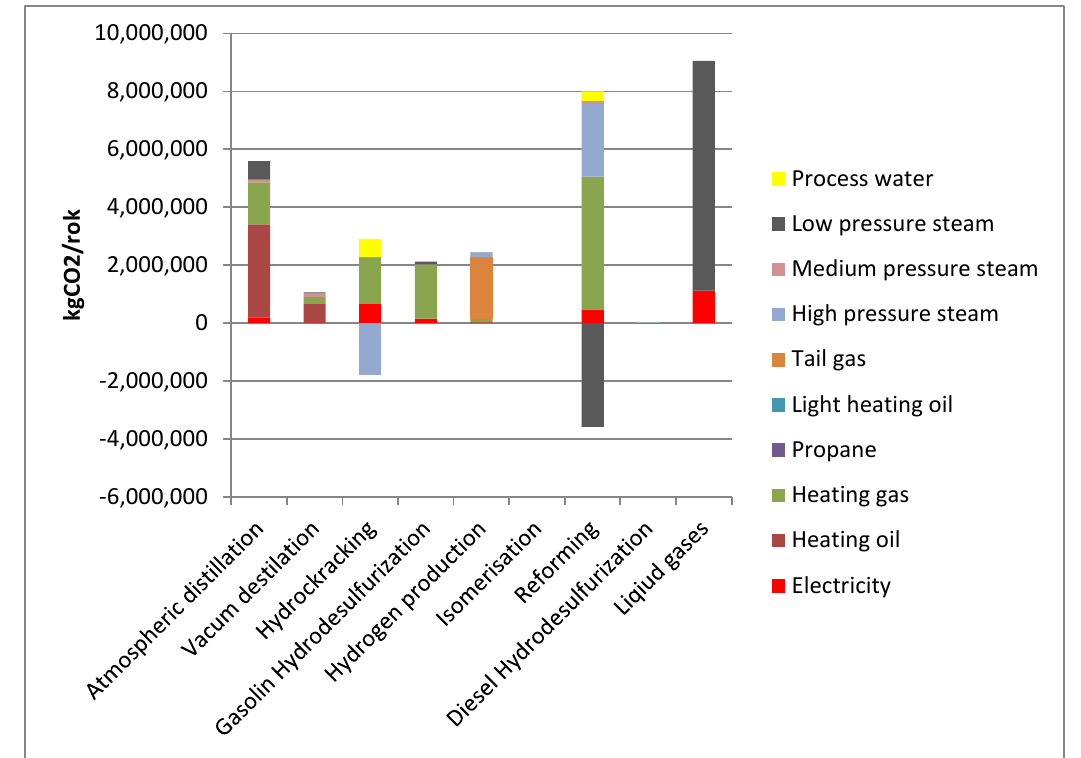
Figure 6. Annual GHG emissions generated by individual installations after allocation to LPG. Table 3. Life-cycle GHG emissions from motor fuels in the reference case [gCO 2